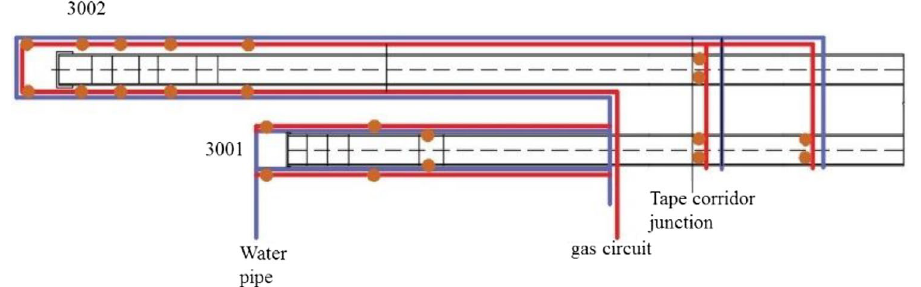
Figure 10. 31 Layout plan of the tape nozzle.